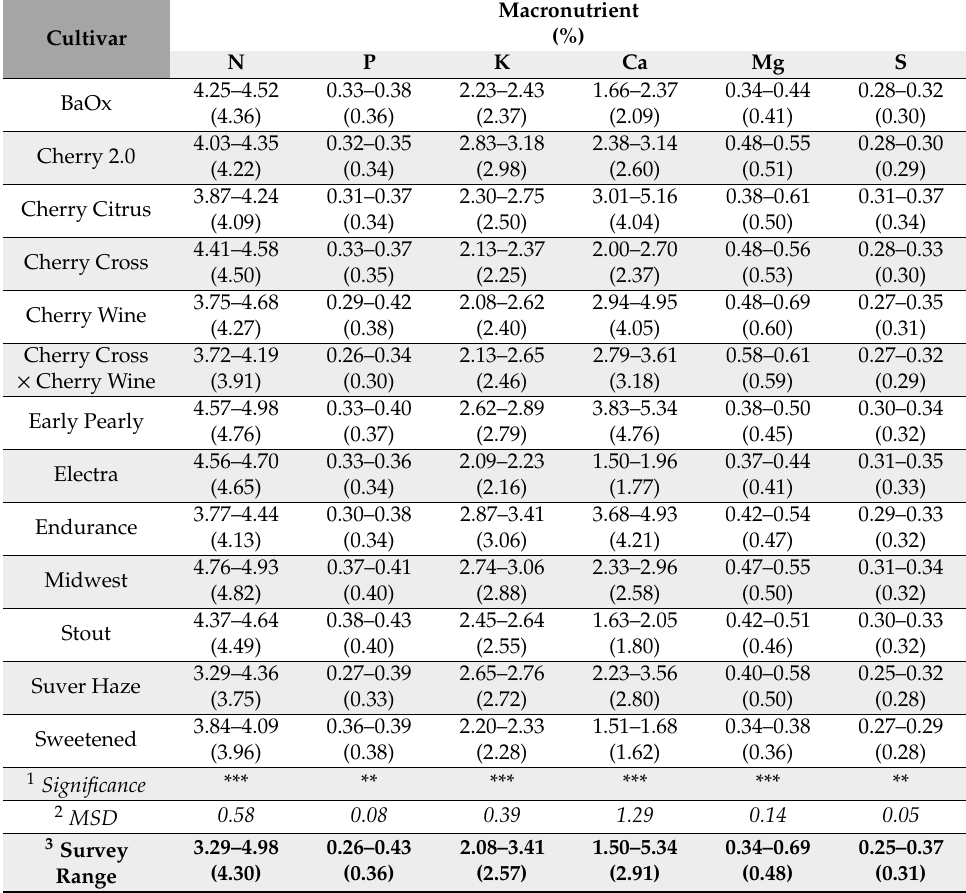
Table 1. Leaf tissue macronutrient concentration ranges for thirteen greenhouse-propagated cannabidiol (CBD) hemp cultivars. Means are delineated in parentheses following each cultivar nutrient range. Plants were 12 weeks old and in a vegetative stage of development prior to the excision of initial cuttings for propagation.